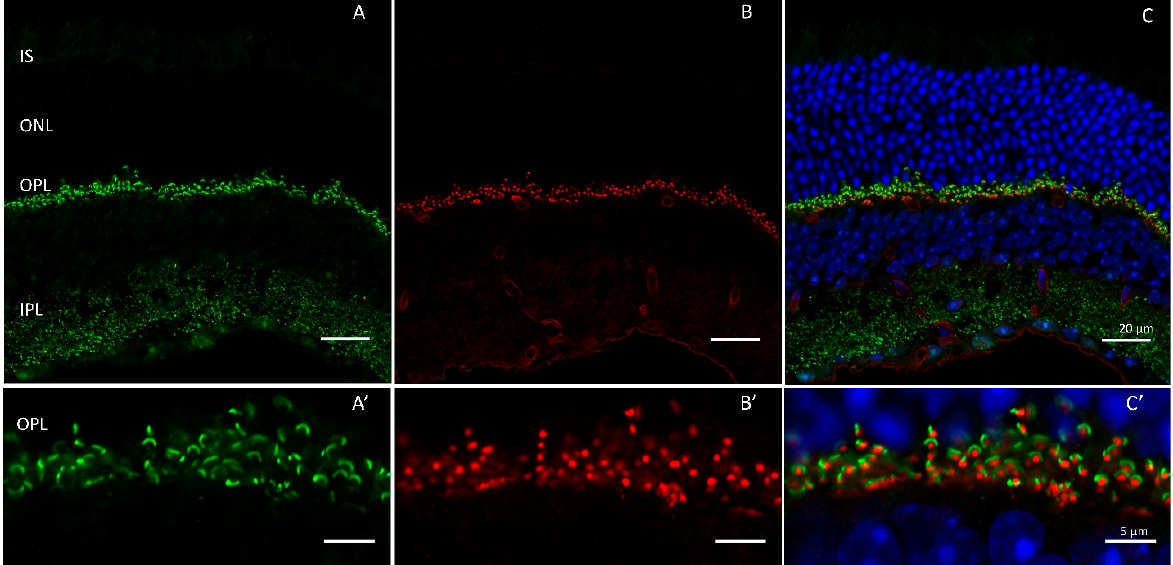
Figure 6. Dystrophin expression in the mouse retina is localized to the outer plexiform layer of the retina where it complexes with dystroglycan. Shown is antibody staining of an adult wildtype mouse retina labeled with ( A ) Ribeye (green) and ( B ) dystrophin (red). ( C ). Merged. Outer plexiform layer shown in ( A’ – C’ ). Scale bar = 20 µm in ( A – C ) and 5µm in ( A’ – C’ ).